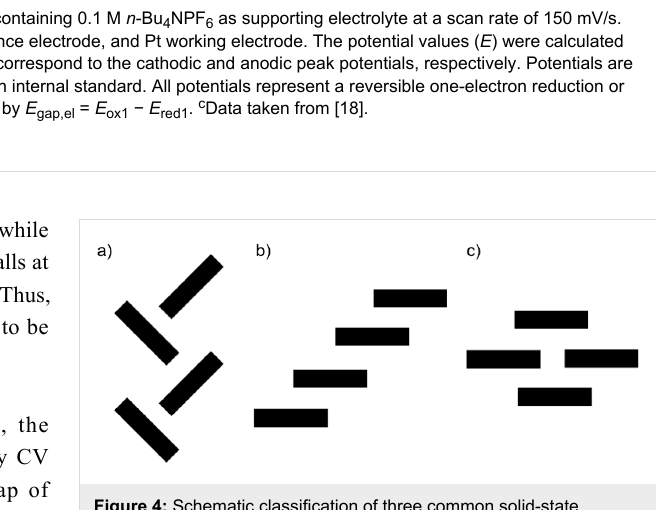
With the understanding that the solid-state packing of acenes can provide vital information about intermolecular interactions, single crystals of pentacenes 3a – d and 3g – j were grown and their solid-state arrangements determined by single crystal X-ray diffraction analysis (crystallographic details are provided in Supporting Information File 1). Pentacene 3a crystallizes in the space group C 2/ c with eight molecules in the unit cell (Figure 5). Within the solid-state structure, the pendant phenyl ring and the pentacene core are slightly twisted, with a torsion angle of ~71°. Molecules of pentacene 3a arrange as dimeric pairs, which then pack into a so-called sandwich herringbone motif (Figure 5c) [50]. Each dimeric pair of pentacenes shows face-to-face π -stacking interactions with an interplanar distance of ~3.40 Å and a total overlap of nearly four of the aromatic pentacene